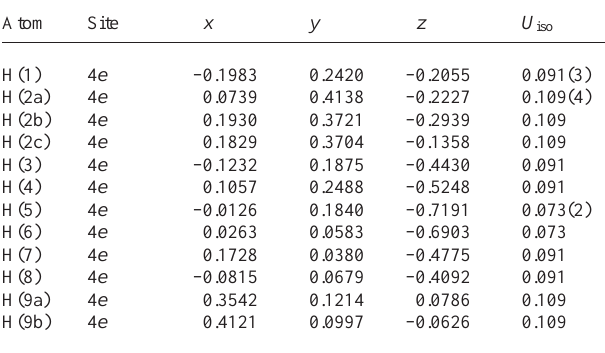
Table 2. Atomic coordinates and displacement parameters (in Å 2 )